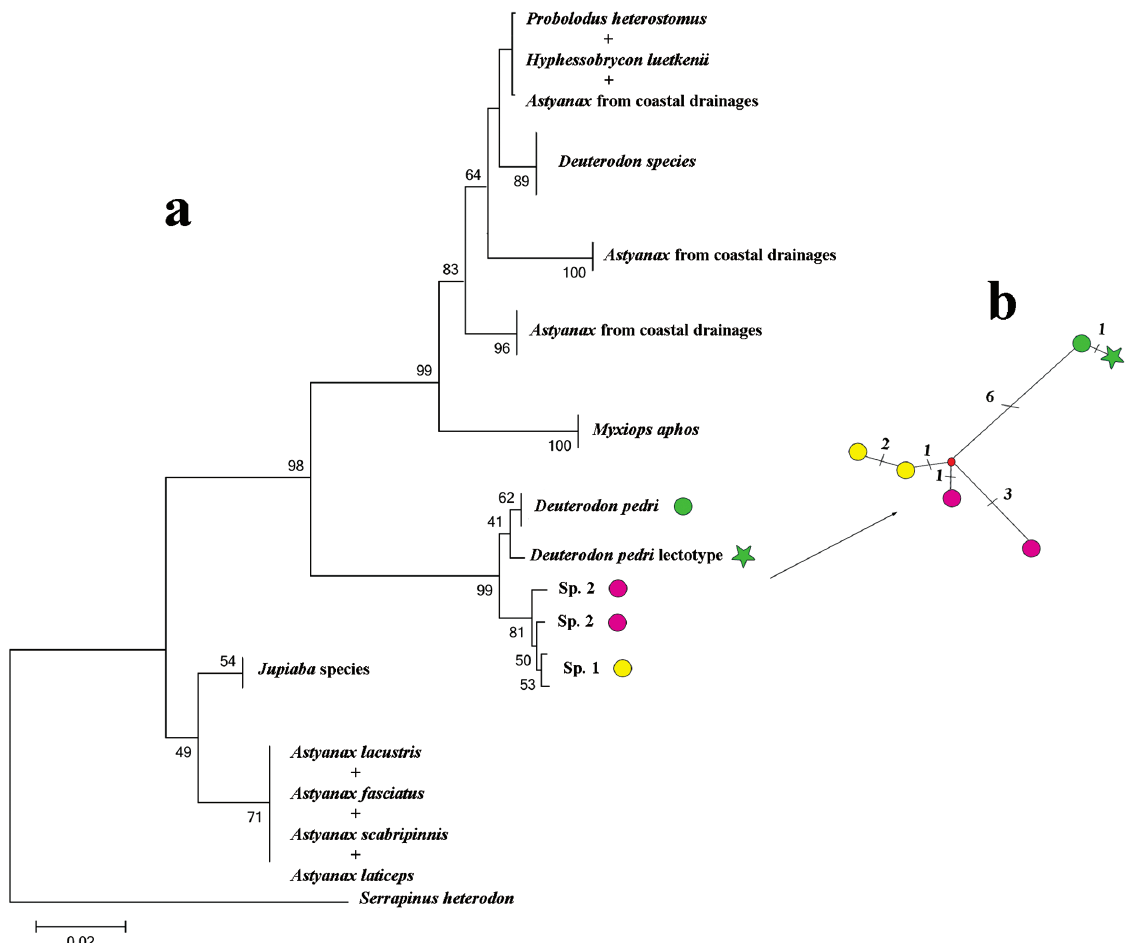
Fig. 2. Neighbor Joining tree and Haplotype network showing high similarity between specimens collected at rio Santo Antônio basin and sequence of the lectotype of Deuterodon pedri . a. Neighbor joining tree with bootstrap values. b. Haplotype network of D. pedri clade. Numbers in each branch of the net refer to number of mutational steps between haplotypes. Morphological analyses of type specimens and of specimens identified by Eigenmann as Deuterodon pedri